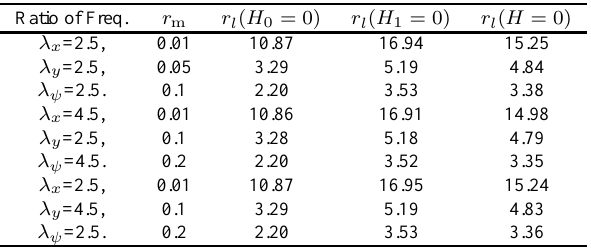
Table 2 Effect of ratio of exciting frequency to natural frequencies of the vibrat-